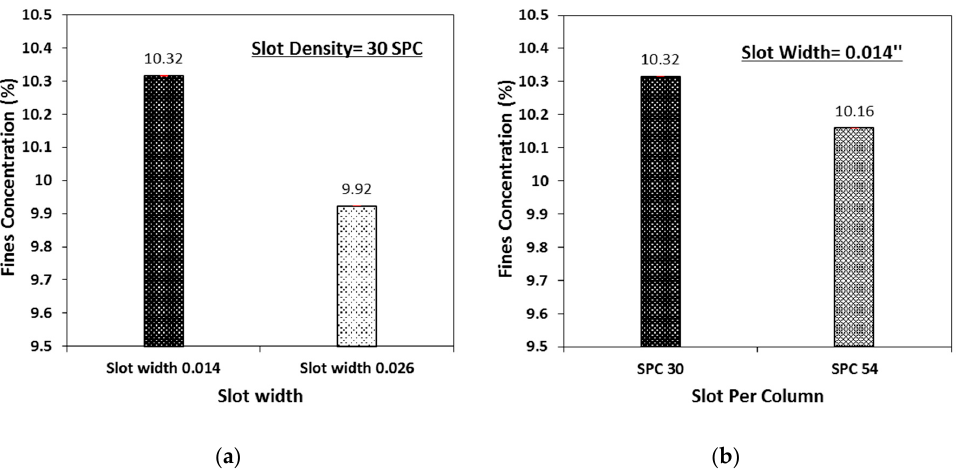
Figure 11. ( a ) Effect of slot width on concentration of fines near the liner, ( b ) effect of slot density on concentration of fines near the screen.